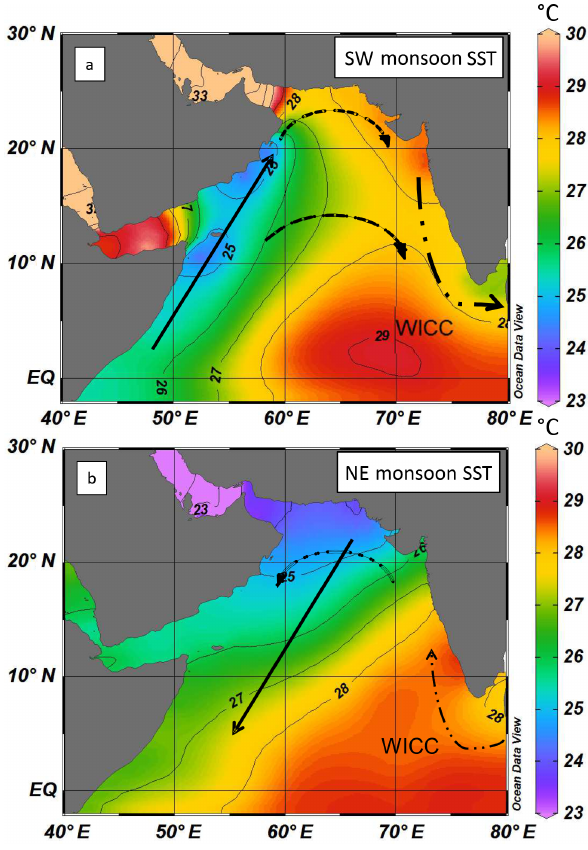
Figure 2. SST in ◦ C from Jul–Sep (SW monsoon) (a) and Jan– Mar (NE monsoon) (b) from the World Ocean Atlas (Locarnini et al., 2013). Solid arrows indicate major wind directions and broken arrows indicate surface general currents; WICC is the West Indian Coastal